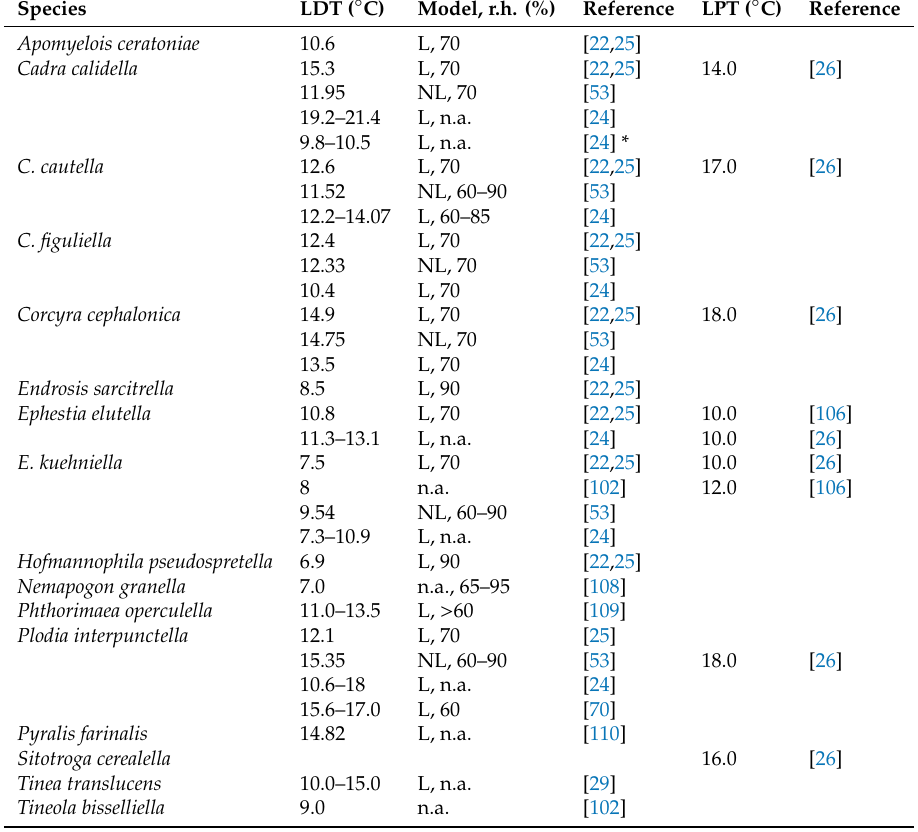
Table 3. Threshold temperatures for the individual (LDT) and population (LPT) development of selected stored product moths. L–estimated based on linear model, NL–estimated based on non-linear model, n.a.–data are not